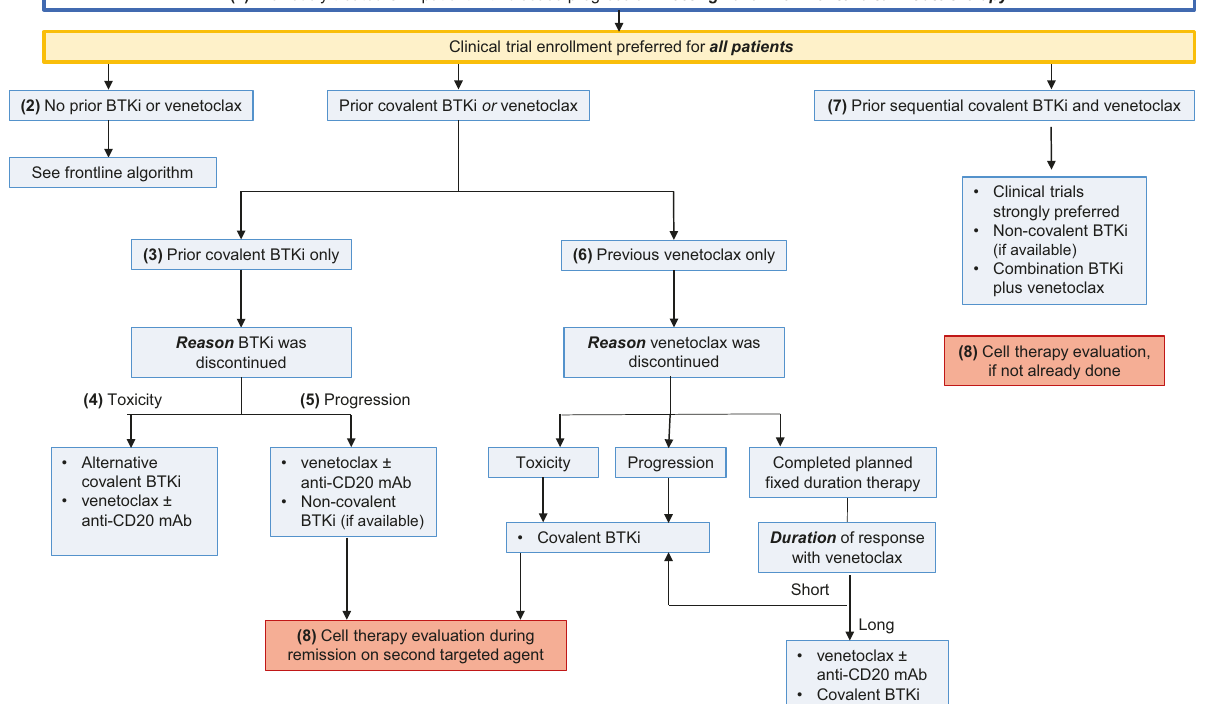
Fig. 4 Approach to the management of patients with relapsed CLL who meet the 2018 International Workshop for Chronic Lymphocytic Leukemia (iwCLL) criteria for therapy. BTKi Bruton tyrosine kinase inhibitors, IGHV immunoglobulin heavy chain gene, mAb monoclonal